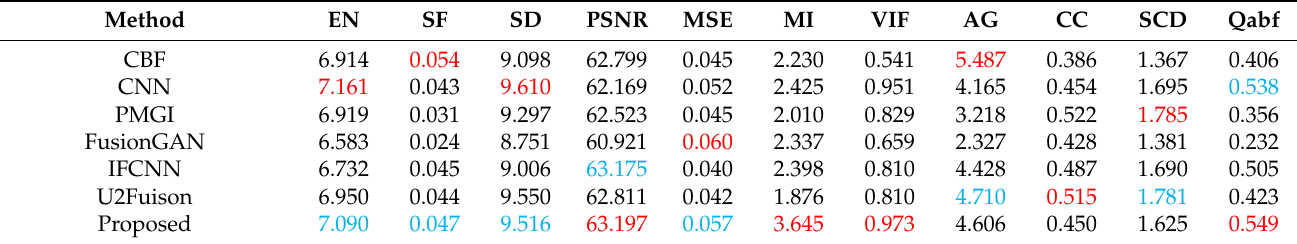
Table 5. The objective experimental results of different fusion methods show that the red font is optimal, and the blue font is